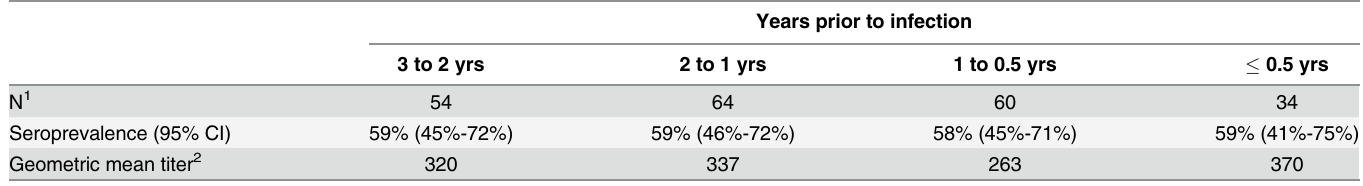
Table 2. Pre-epidemic DENV-2 neutralizing antibody profiles of participants with subsequent confirmed DENV-2 infection in 2010 – 2011. Seroprev- alence is based on a cutoff titer of 60. Geometric mean titers (GMT) are based on samples with detectable titers.